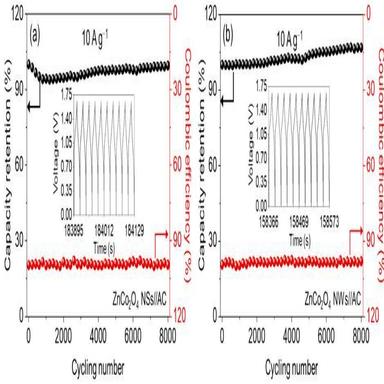
The cycling performance and Coulombic efficiency of (a) ZnCo2O4 NSs//AC HSC and (b) ZnCo2O4 NWs//AC HSC, and the insets were the GCD curves of last ten cycles.